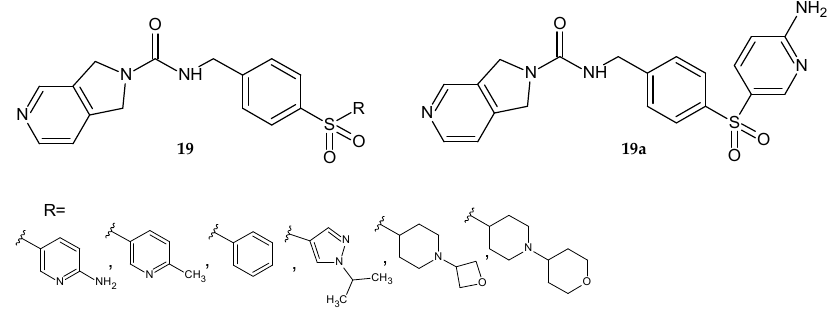
Figure 14. 4 ‐ Sulfonylobenzyl ‐ derivatives of pyrrolo[3,4 ‐ c ]pyridine ‐ 2 ‐ carboxamide 19 as potent inhibitors of NAMPT and the most active compound 19a . Wojcicka et al. [20] synthesized a series of 4-methyl-6-phenylpyrrolo[3,4- c ]pyridine-1,3- dione derivatives by modifying of the substituent at position 2 of the pyrrolo[3,4 c ]pyridine scaffold (Figure 15). N -alkil-4-methyl-6-phenyl-1 H -pyrrolo[3,4- c ]pyridine-1,3-diones 20a – s were obtained and screened for their antitumor activity in vitro. Mannich bases 20g – s with an IC 50 value in the range of 19–29 µ g/mL were the most